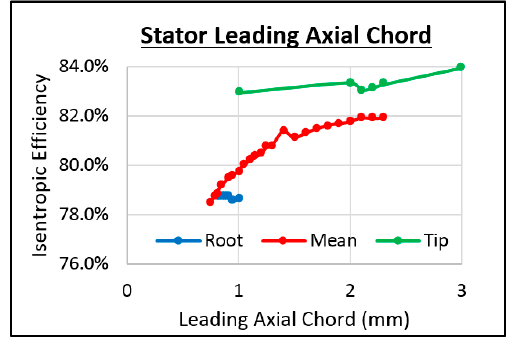
Figure 25. Study of the stator leading axial chord.